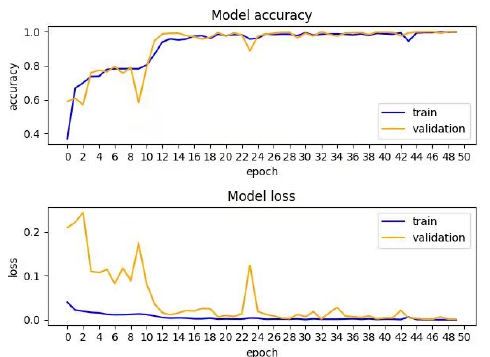
Figure 10. Accuracy loss curve of CNN-CBAM-BiLSTM model.